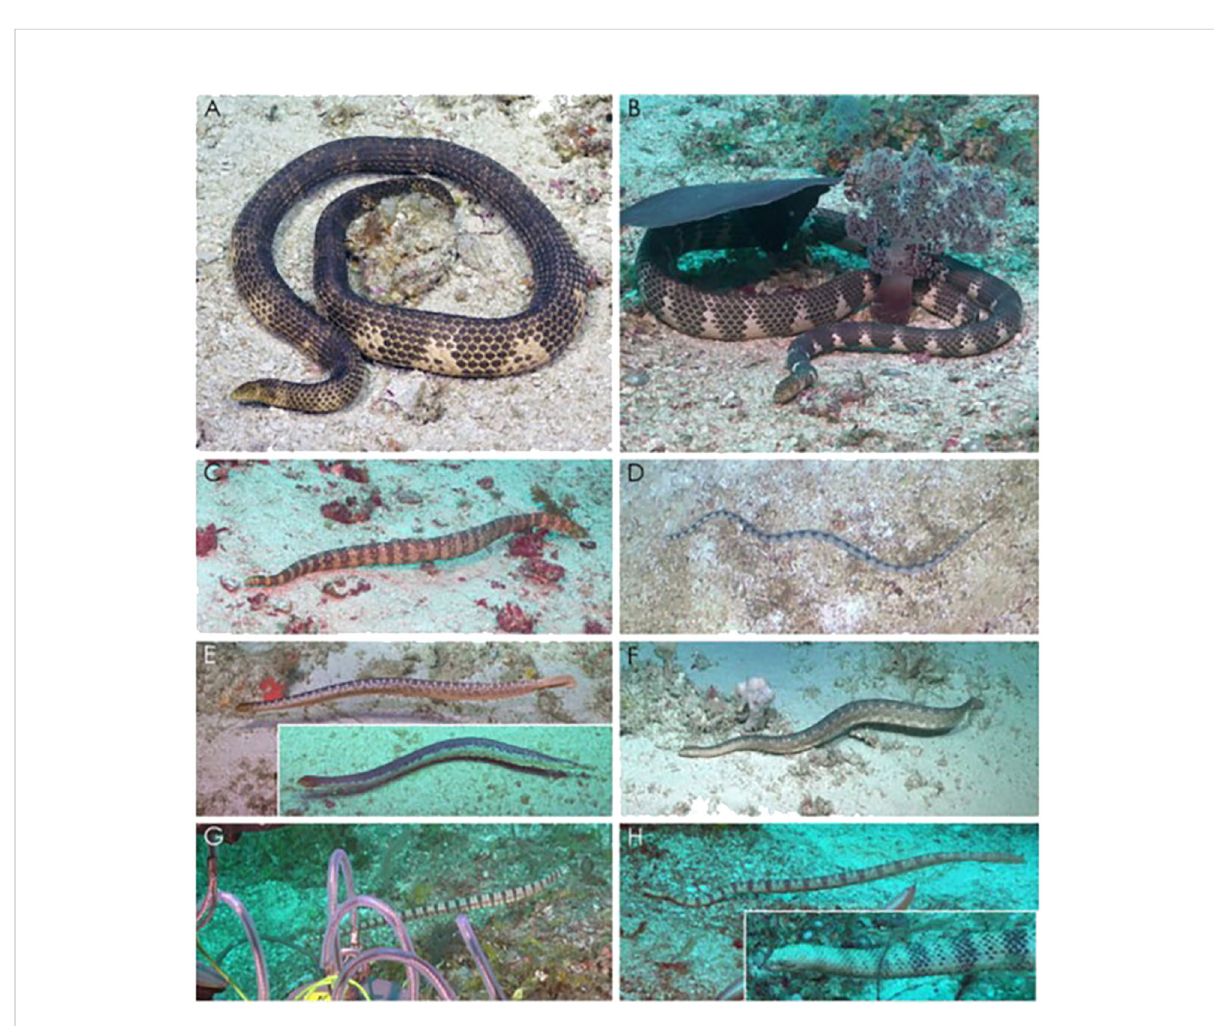
FIGURE 3 Photographs of sea snakes obtained during the ROV survey at Ashore Reef in 2021. (A) Aipysurus apraefrontalis, (B) Aipysurus duboisi, (C) Emydocephalus orarius, (D) Hydrophis coggeri, (E) Aipysurus laevis (colour variations), (F) Hydrophis ocellatus, (G) Hydrophis kingii, and (H) Hydrophis peroni (with closeup of head). Reproduced from Speed et al.